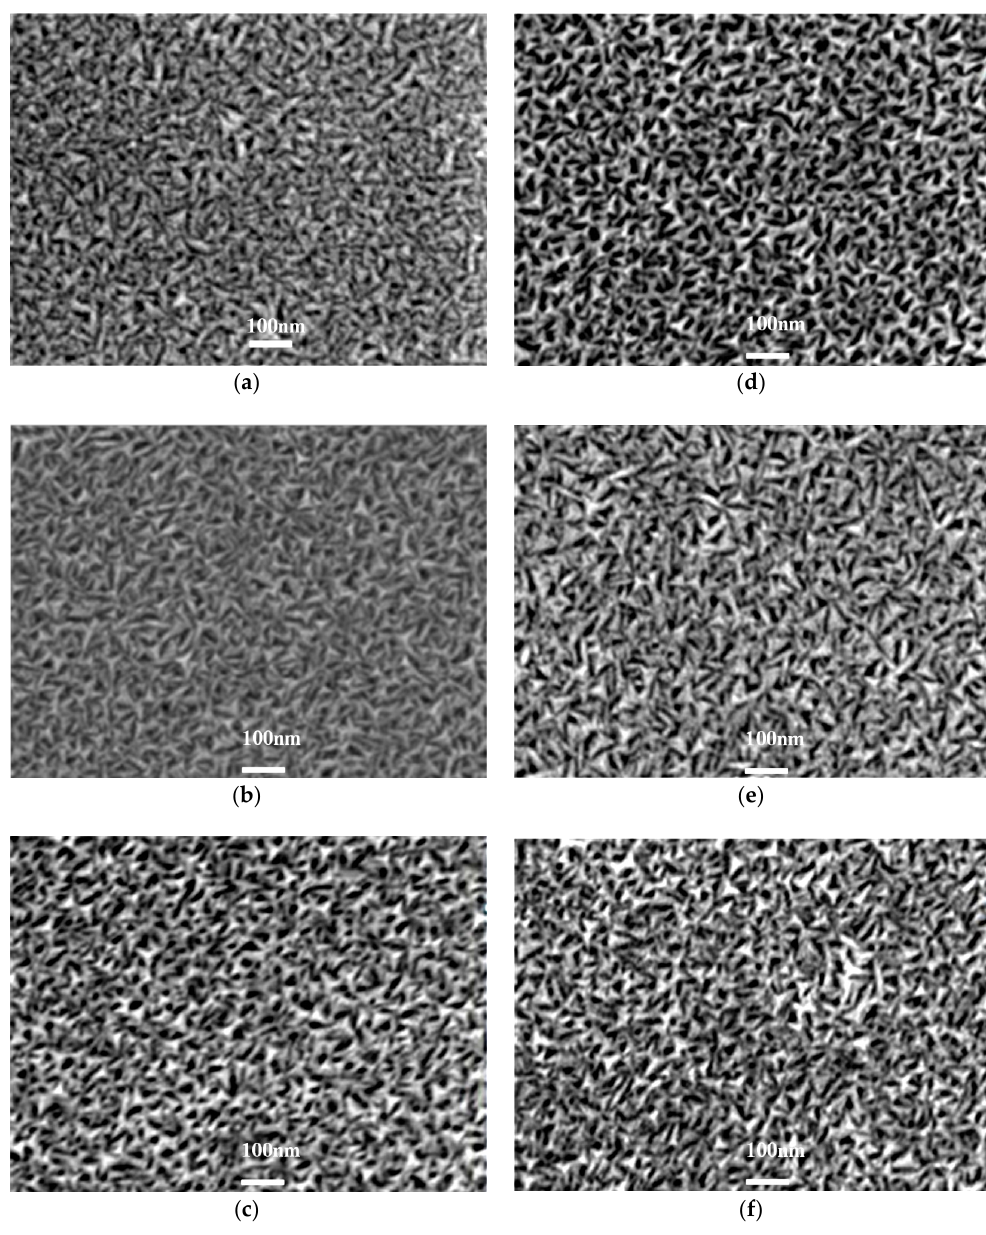
Figure 2. SEM images of Mo films deposited at different substrate temperature—( a ) RT; ( b ) 200 °C; and ( c ) 400 °C—and at various annealing temperatures—( d ) 100 °C; ( e ) 200 °C; ( f ) 400 °C, respectively. Table 2. The resistivity, grain size, Hall mobility, carrier concentration and RMS roughness of Mo thin films prepared in different heating modes at different temperatures.